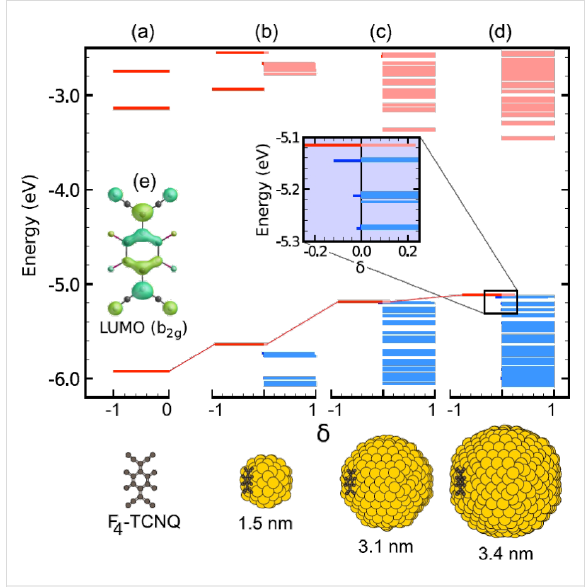
Figure 3: Hybridization between F 4 -TCNQ and Si NC one-electron states. (a) Isosurface plot of the F 4 -TCNQ lowest unoccupied state (b 2g symmetry), and (b–e) Kohn–Sham eigenvalue energy diagrams. The energy-level diagrams are for (a) isolated F 4 -TCNQ and (b–e) for F 4 -TCNQ adsorbed on Si NCs of increasing size. Each state is repre- sented by a bar of unitary length, with the abscissa of the left- and right-hand ends of the bar indicating, respectively, the relative localiza- tion on the molecule (negative values) and on the NC (positive values). Reprinted with permission from [20]. Copyright 2011 The American Physical